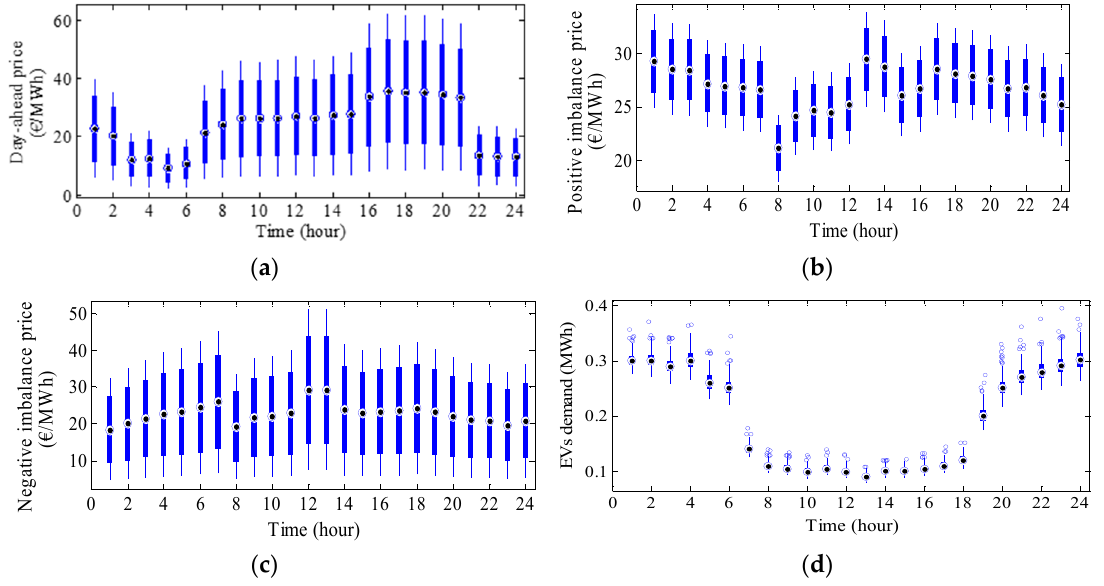
Figure 3. Scenarios of ( a ) day-ahead prices; ( b ) positive balancing prices; ( c ) negative balancing prices; ( d ) EV demand.